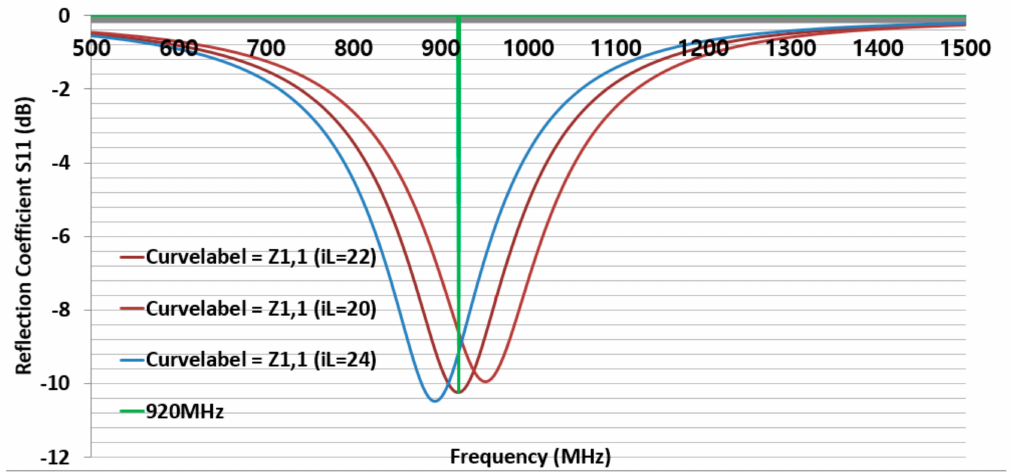
Figure 4. Return loss of the design CFTA M4023 by parameters of iL = 20, 22, 24